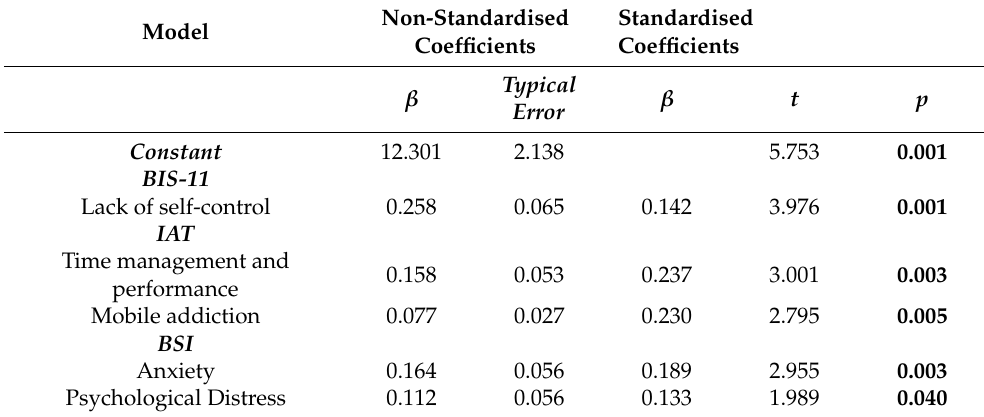
Table 6. Hierarchical regression between IA (Total Phubbing Scale) and the rest of the study variables in the total